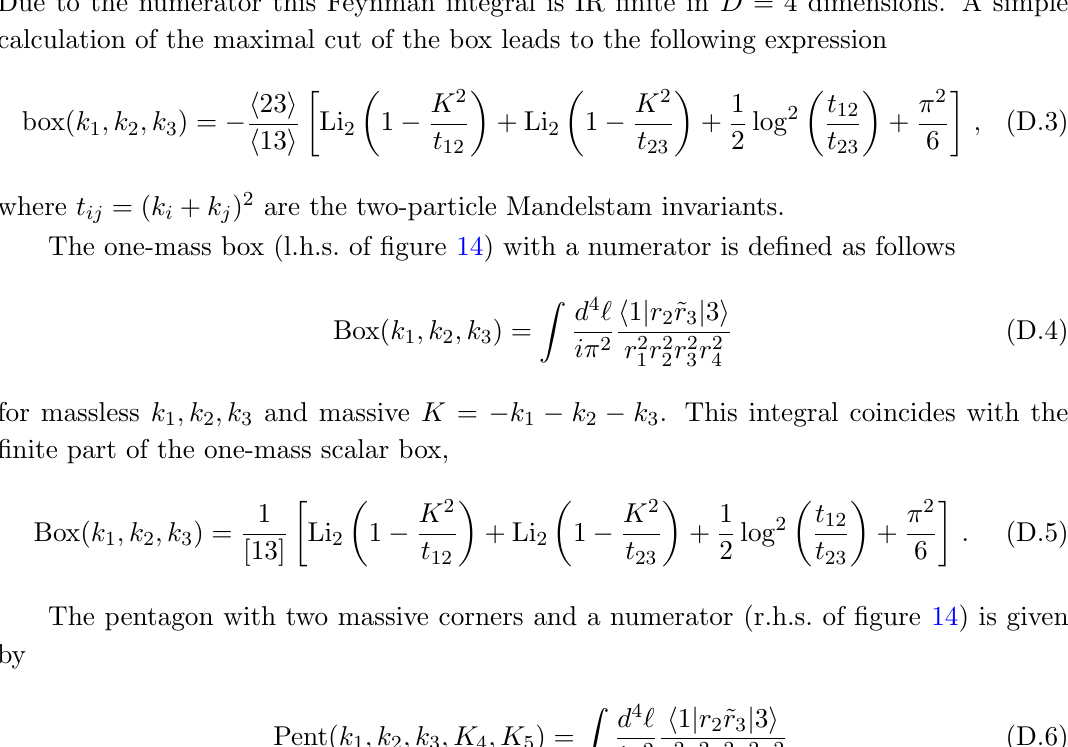
1 r 2 ~ r 3 3 de(cid:12)ned in h j j i